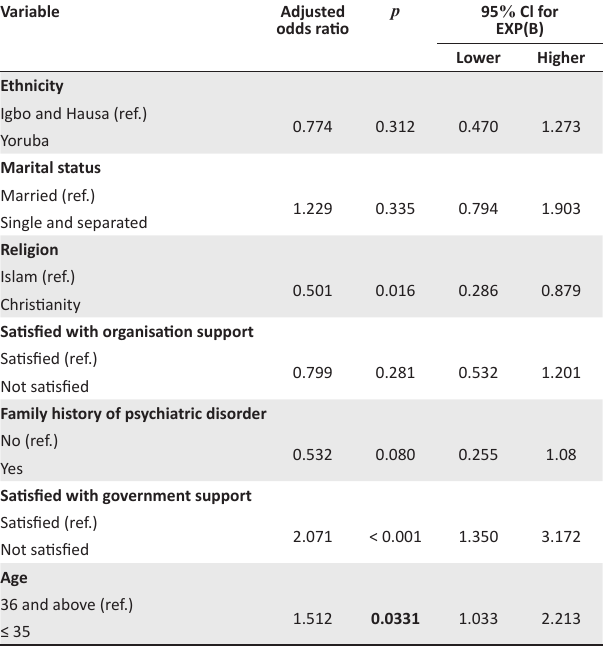
TABLE 4: The socio-demographic variables independently associated with depression by logistic